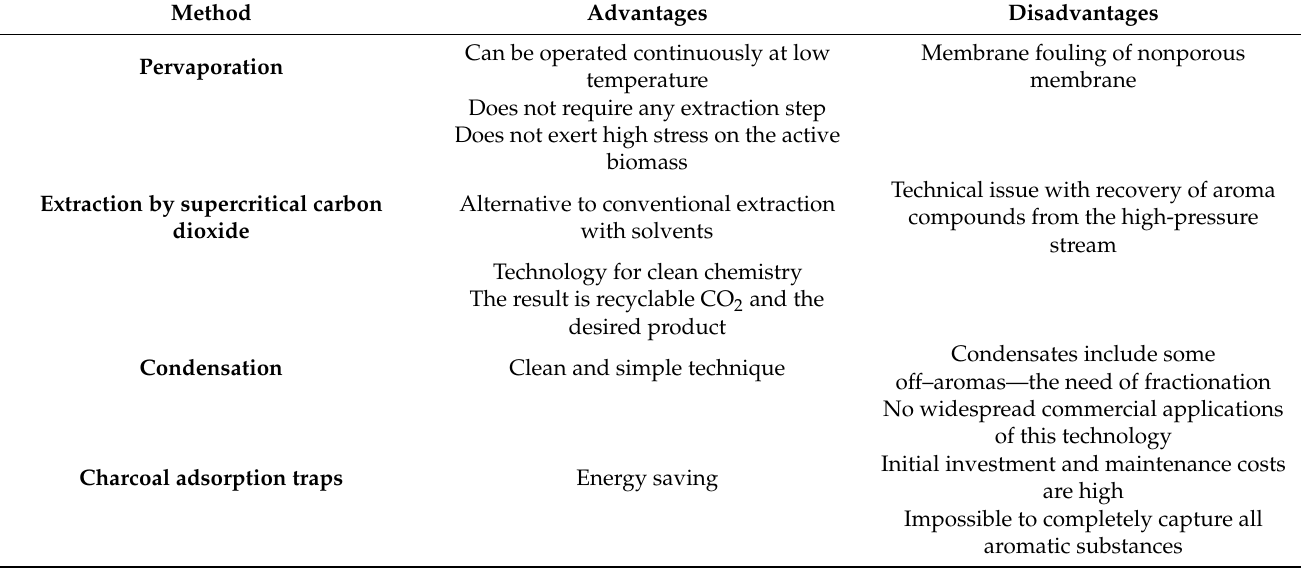
Table 3. Capture and aroma recovery techniques